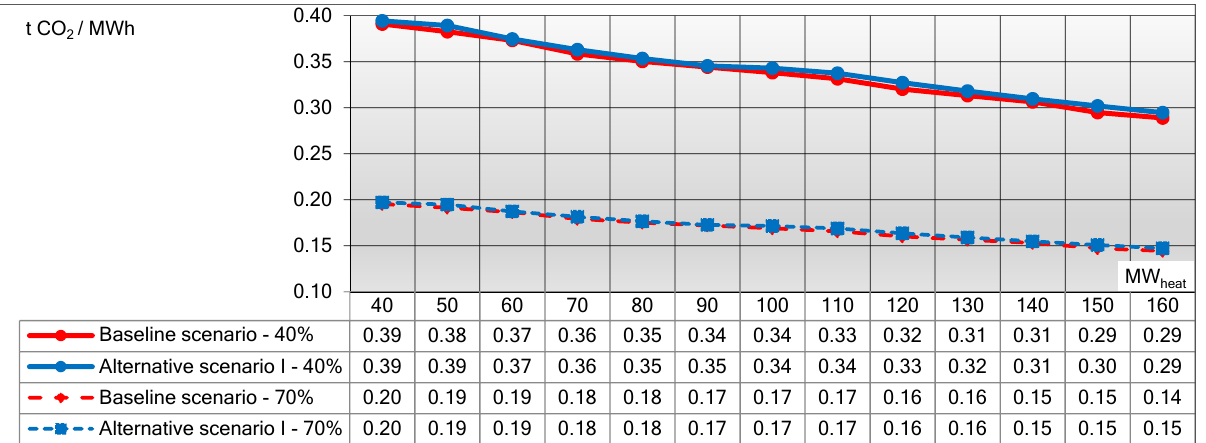
Figure 8. CO 2 emissions under baseline scenario and alternative scenario I from a mix of oil shale and biomass (40% and 70%).